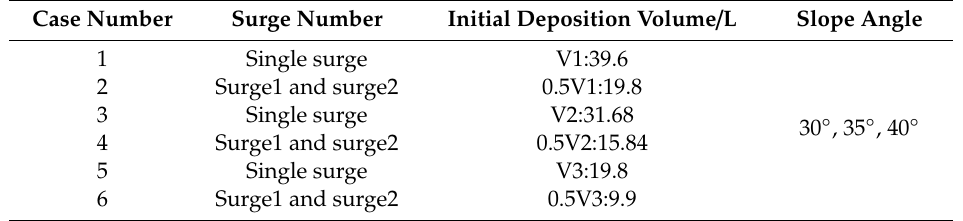
Table 2. DEM simulation